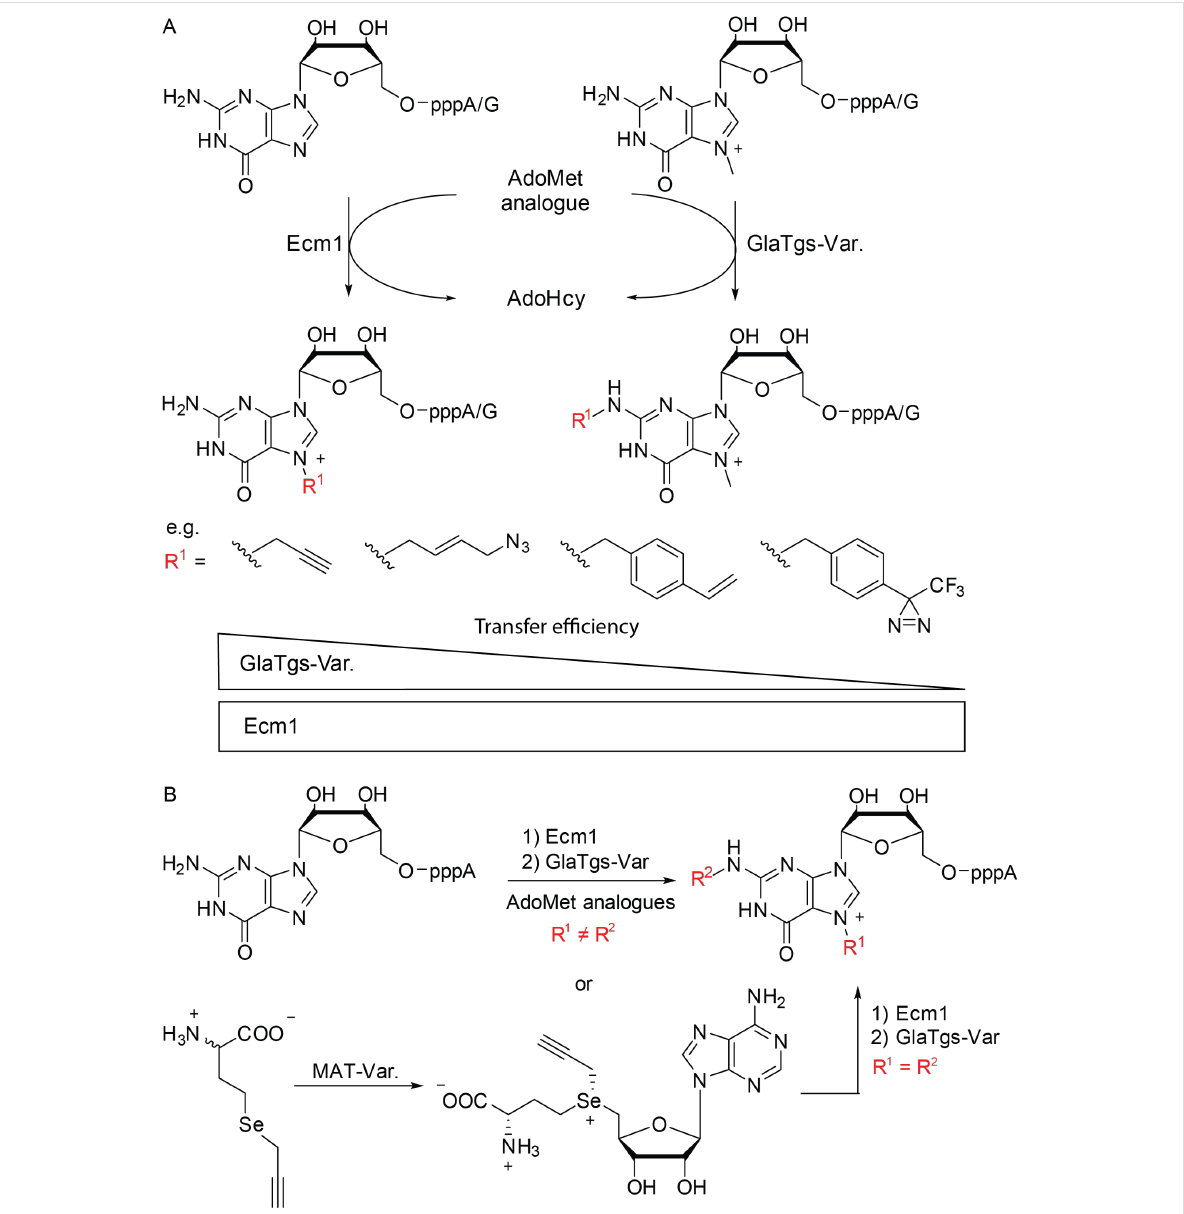
Figure 5: Enzymatic modification of cap analogues at their N 2 - or N 7-position or a combination of both. (A) Functional moieties such as alkynes and azides can be enzymatically transferred to the N 2 -position using GlaTgs-Var. or N 7-position using Ecm1 [88-91]. While transfer efficiencies decrease with increasing sterical demand when using GlaTgs-Var., transfer efficiencies are largely independent of size with Ecm1. (B) Both enzymes can be combined to yield dual or double modified cap analogues. The AdoMet analogue can also be prepared enzymatically starting from a (seleno)-methio- nine analogue and a MAT-Var